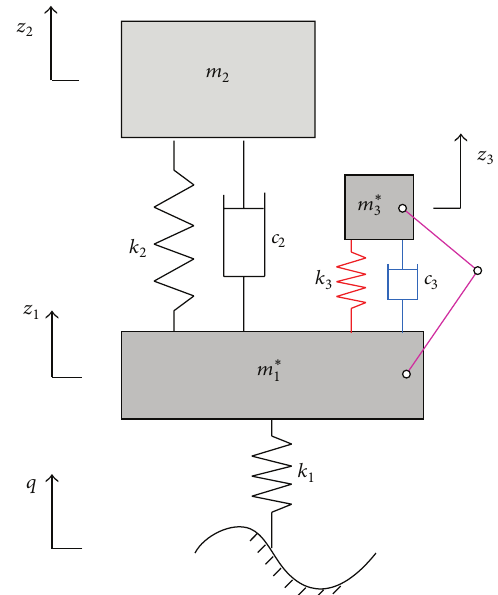
Figure 5: A quarter vehicle model of three